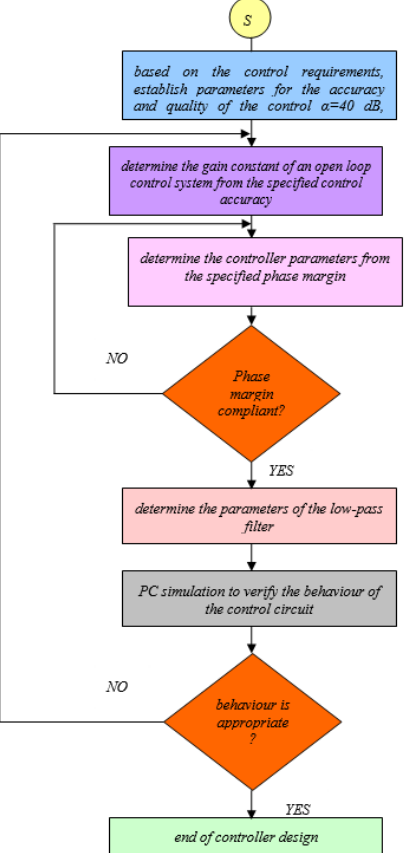
Figure 18. Flowchart of the controller design algorithm.